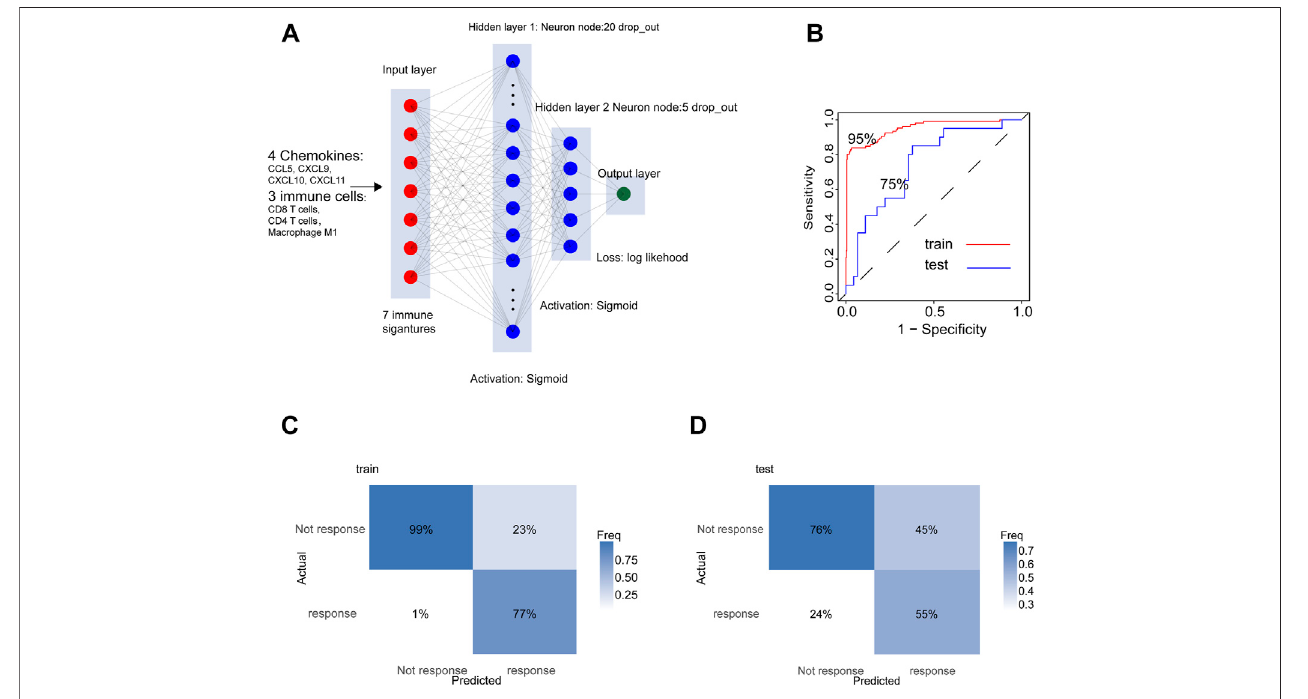
FIGURE 8 | The four chemokines and three immune cells were used to construct a neural network model to predict the response to anti-PD-1/PD-L1 immunotherapy. (A) Schematic diagram of the neural network. (B) ROC plot of train cohort and test cohort. (C,D) The confusion matrix in test cohort and train cohort.